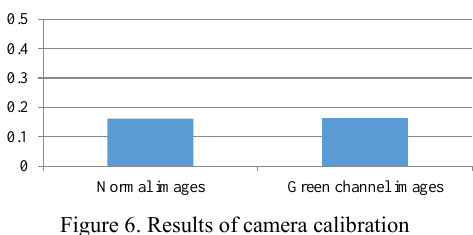
Figure 6. Results of camera calibration using green channel images